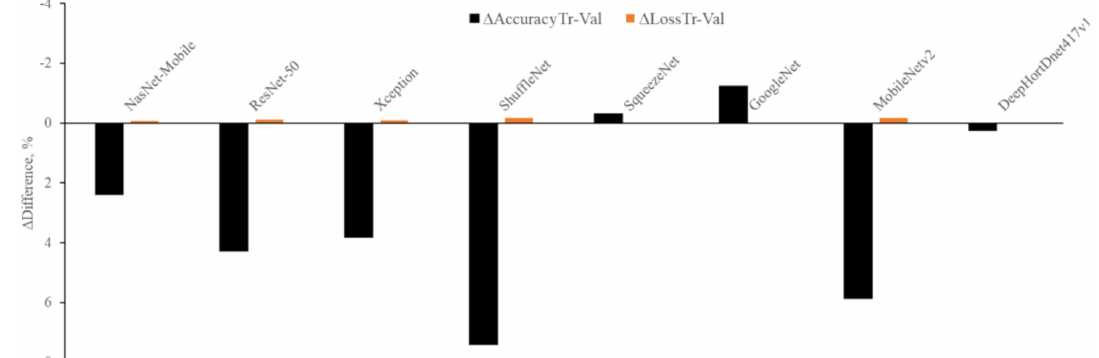
Figure 6. Visualization of network stability.